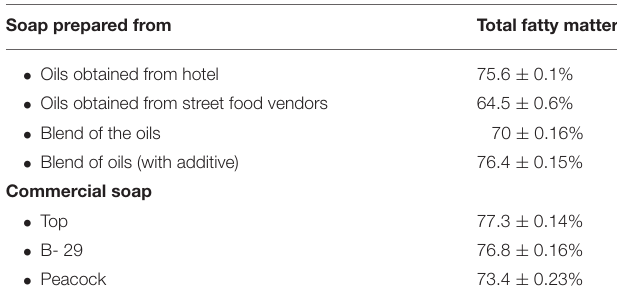
TABLE 4 | The total fatty matter values of the prepared and commercial soap samples.